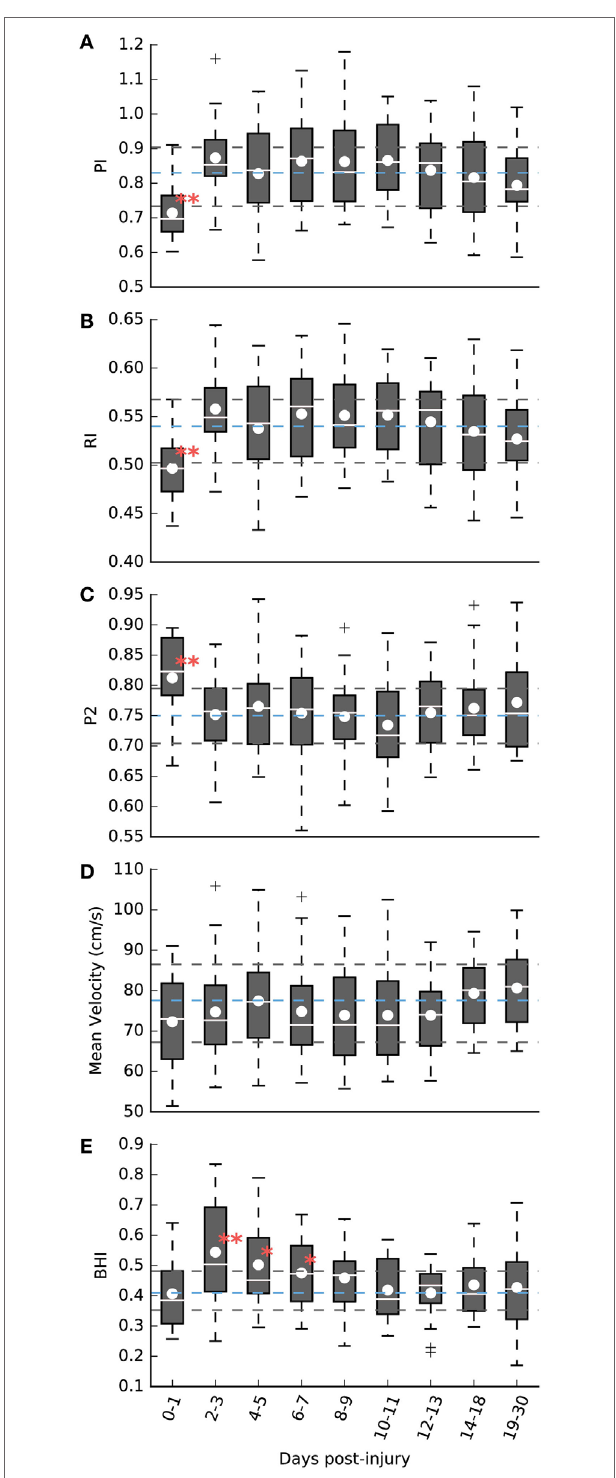
FigUre 3 | (a–D) Pulsatile analysis of the baseline exam period over different days post-injury. (a) Pulsatility index (PI). (B) Resistivity index (RI). (c) P2 ratio. (D) Mean velocity (MV, cm/s). (e) Cerebrovascular reactivity (CVR) analysis—breath hold index (BHI). ** P < 0.01, * P < 0.05. The dashed blue lines represent the control population mean with interquartile range marked by the surrounding dashed black lines.